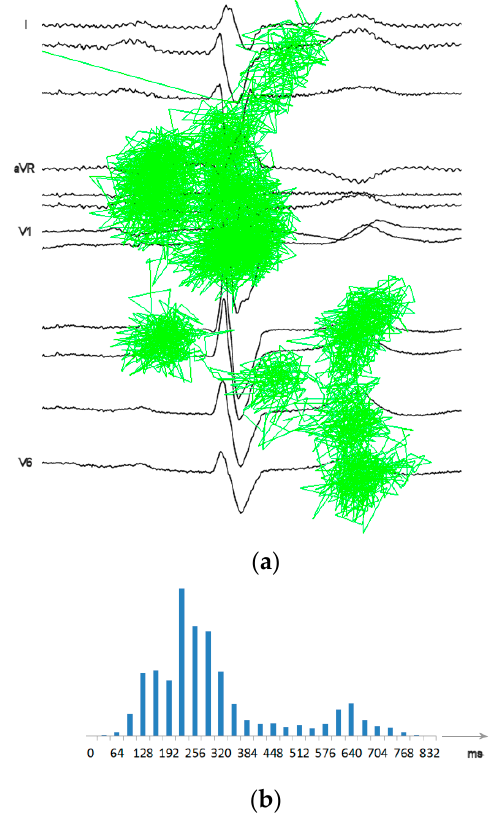
Figure 2. ( a ) The example of expert’s eyeglobe trajectory over a 12-lead ECG plot (CSE-Mo-001); ( b ) Corresponding bar graph of the attention density (each bar collects gaze time in a 32 ms interval in ECG record)—the background for gMRF (modified from [20]).